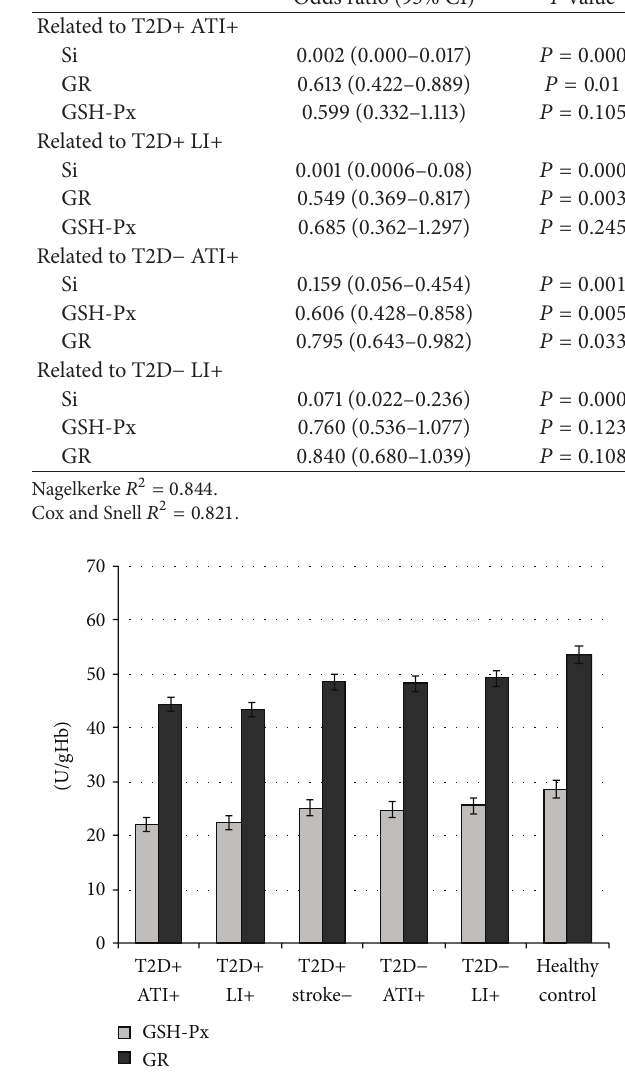
Figure 3: Values are expressed as mean ± SE. Bar graphs show the values of antioxidant enzyme glutathione peroxidase (GSH-Px) and glutathione reductase (GR) activity. GSH-Px and GR levels were lower in type 2 diabetes (T2D) patients with different subtypes of ischemic stroke: atherothrombotic infarction (ATI) and lacunar infarction (LI) compared to T2D patients without ischemic stroke, and the same relationship is found in the respective groups in nondiabetics (𝑃 < 0.001) (ANOVA